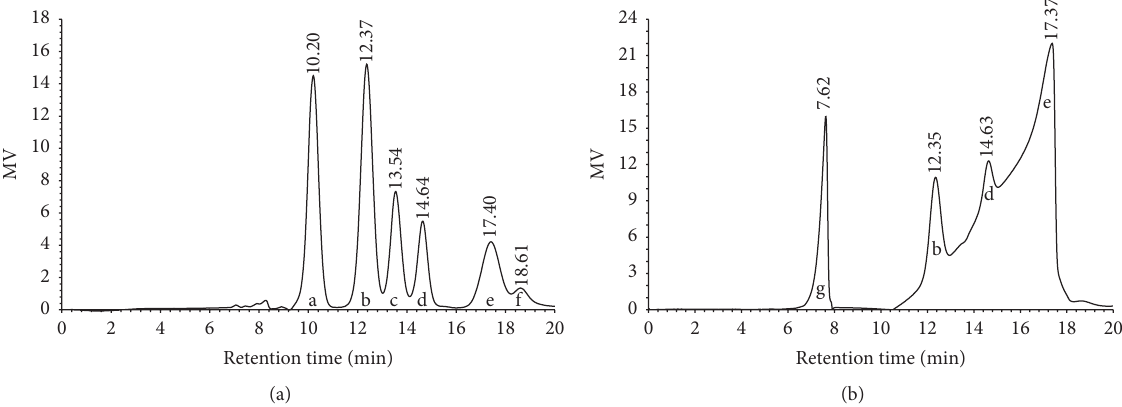
Figure 5: HPLC chromatograms of (a) a standard mixture of sugars and (b) EPS hydrolysate. Peaks a, b, c, d, e, and f correspond to sucrose, glucose, xylose, galactose, mannose, and fructose, respectively. Peak g corresponds to the EPS (not hydrolyzed).